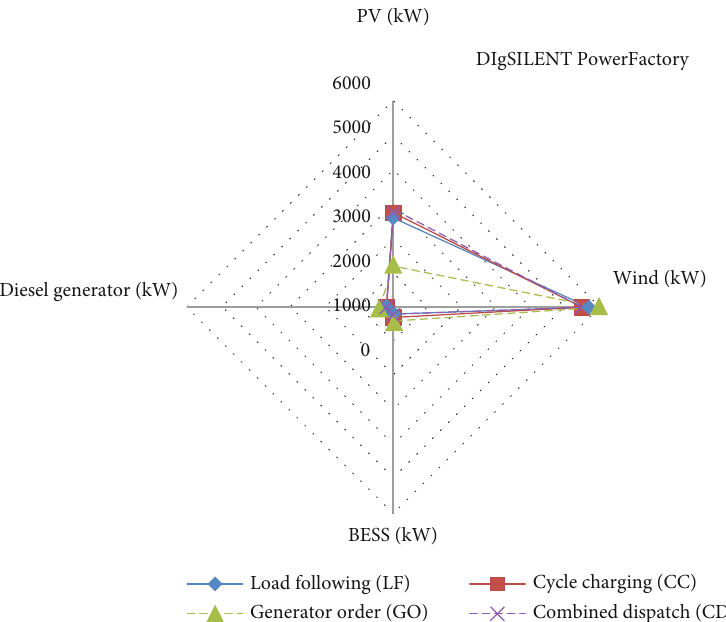
Figure 6: Optimal sizes of each module according to the various dispatch strategies for a proposed islanded hybrid microgrid in the DIgSILENT PowerFactory platform. This fi gure is reproduced from Shezan et al.